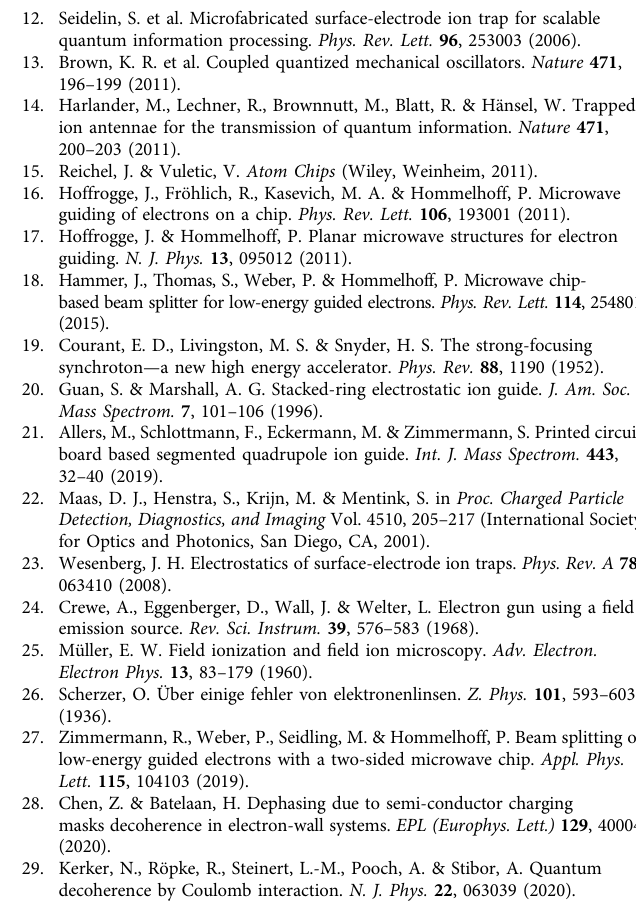
The raw data, i.e., the recorded detector images, that support the fi ndings of this study are available in Zenodo with the identi fi er “ https://doi.org/10.5281/zenodo.4160787 ” . Code availability The code to reproduce the results is available from the corresponding author upon reasonable request.